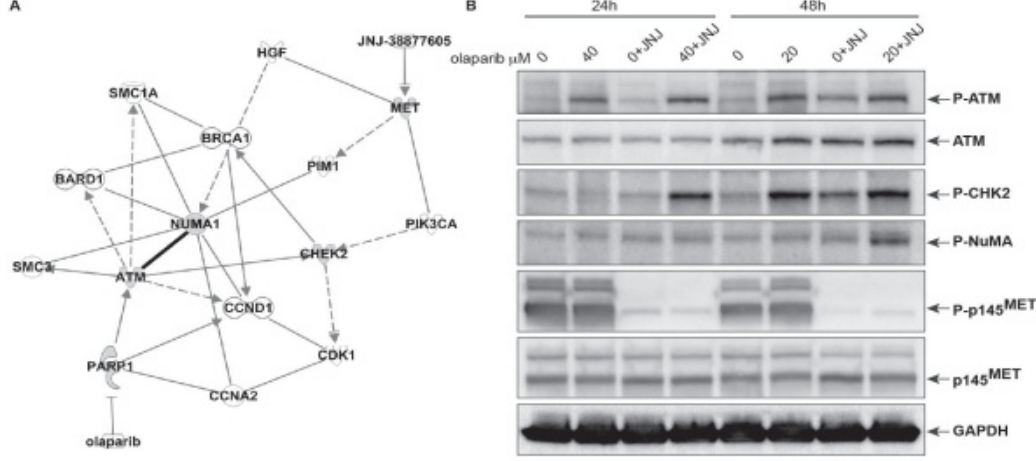
Figure 6. Molecules affected after treatment of the EBC-1 cells with olaparib and JNJ at the indicated concentrations and after the indicated times. ( A ) IPA allowed identifying molecules potentially affected in response to MET and PARP inhibition. ( B ) Western blot analysis of expression and/or phosphorylation of the indicated proteins after cell treatment at the indicated concentrations of olaparib with or without JNJ (100 nM). Proteins examined are: ATM , CHK2 (checkpoint kinase 2), the nuclear mitotic apparatus (NuMA) protein, MET and the Glyceraldehyde 3-phosphate dehydrogenase (GAPDH) used as loading